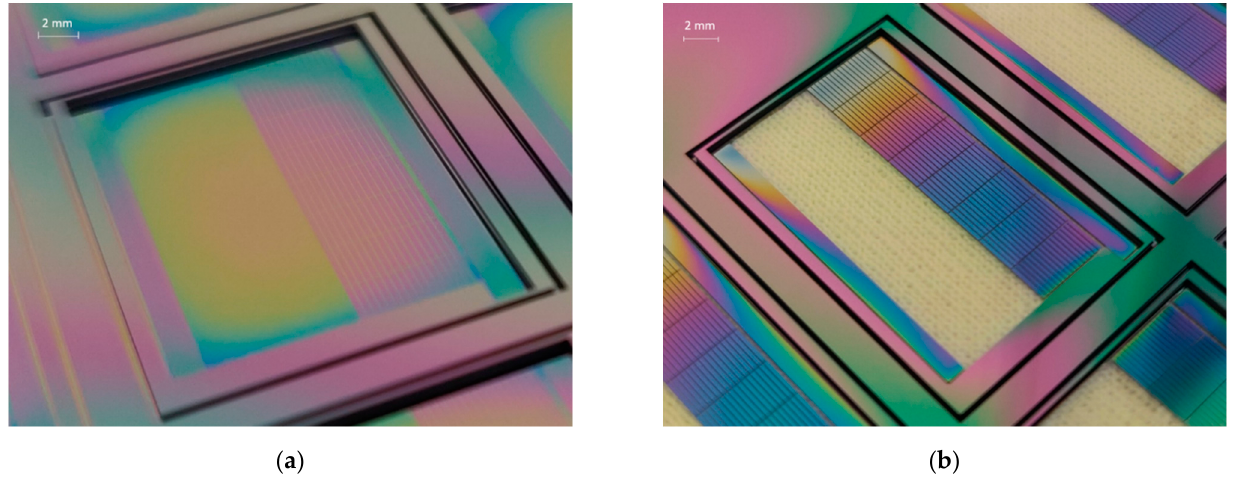
Figure 7. ( a ) Backside etching result of a silicon substrate, landing on cavity-BOX. ( b ) Etching device layer while using the patterned cavity-BOX as a mask, landing on polyimide.